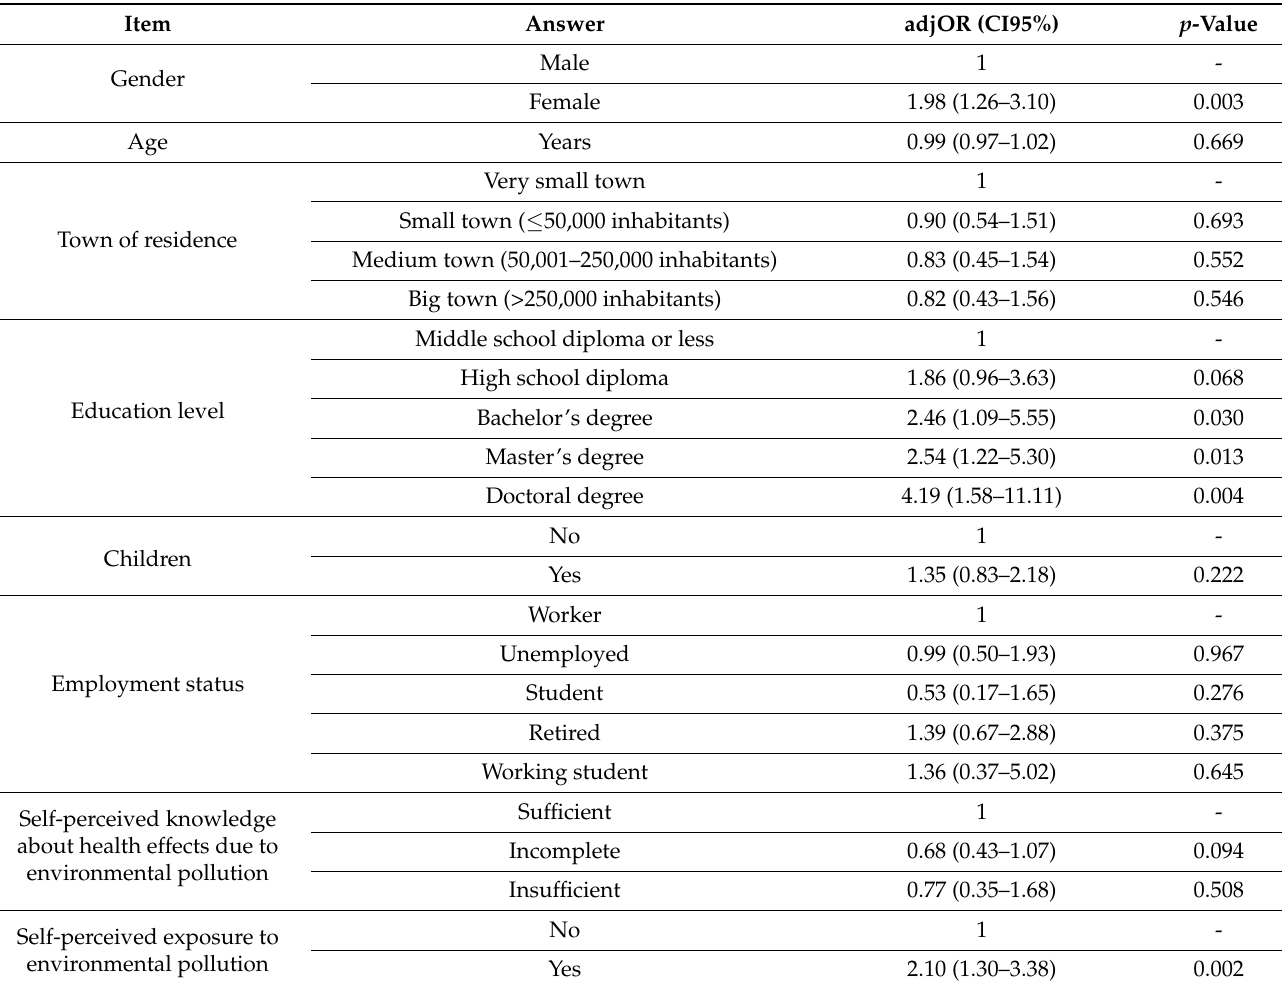
Table 4. Multivariable logistic regression model on the fourth outcome: perceived importance of pro-environmental